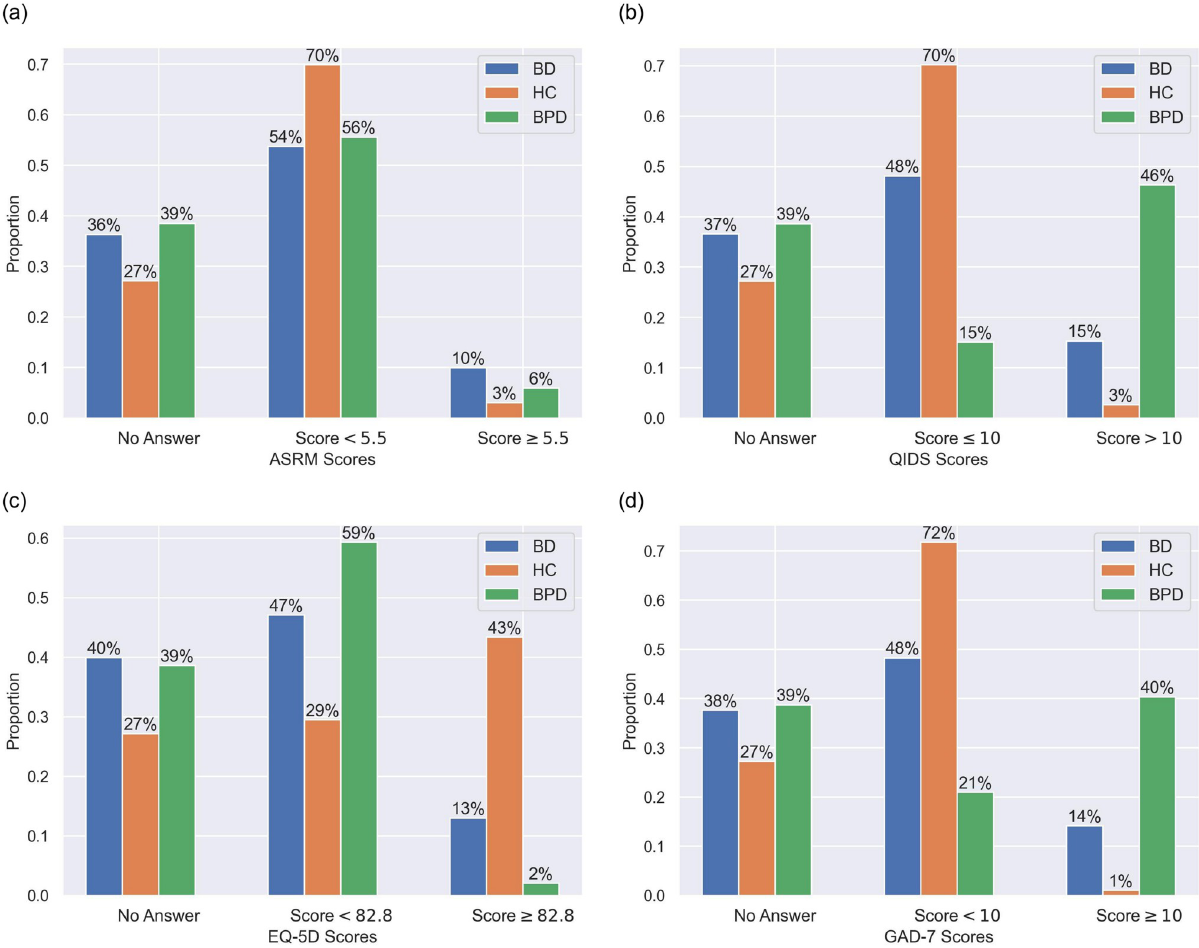
Fig 1. Bar charts: The proportion of time each participant group spent in the respective clinical states for each questionnaire (ASRM, QIDS, EQ- 5D and GAD-7), where the total numbers of weeks for BD/HC/BPD are 3143/2816/1991. (a) ASRM. (b) QIDS. (c) EQ-5D. (d) GAD-7.